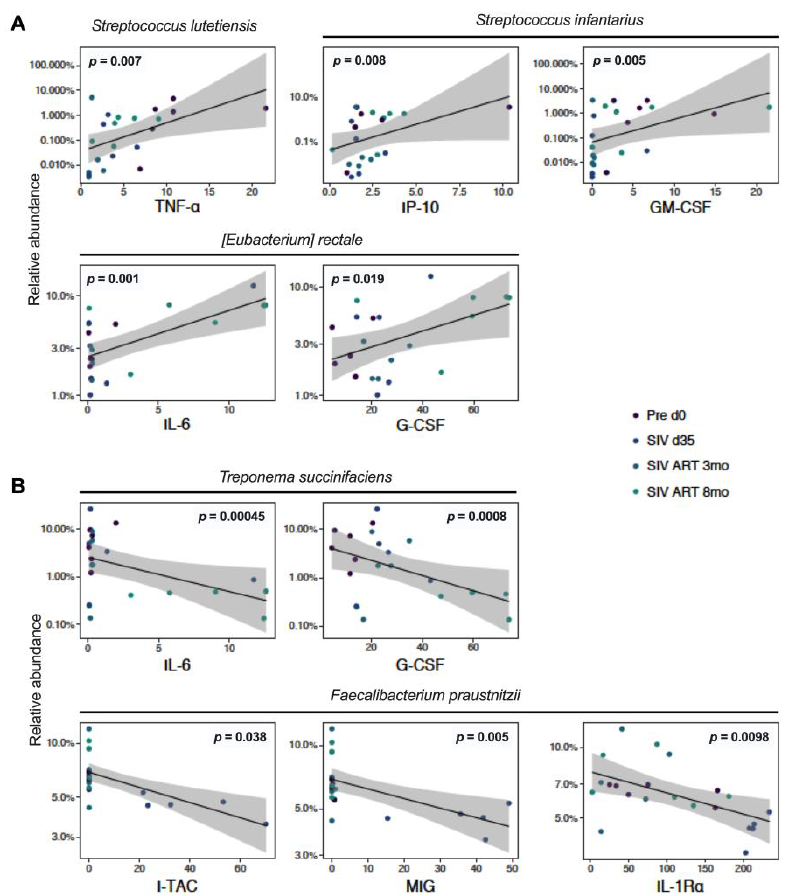
Figure 6. Correlations of gut bacteria with plasma inflammatory cytokines. Logit transformed bacterial relative abundances and plasma cytokine levels with the animal IDs as random effects were correlated using linear mixed effects models to find patterns of host–microbe interactions. ( A ) Species showing a statistically significant positive correlation with inflammatory cytokines; and ( B ) species showing a statistically significant negative correlation with plasma inflammatory cytokines through the course of SIV-ART.